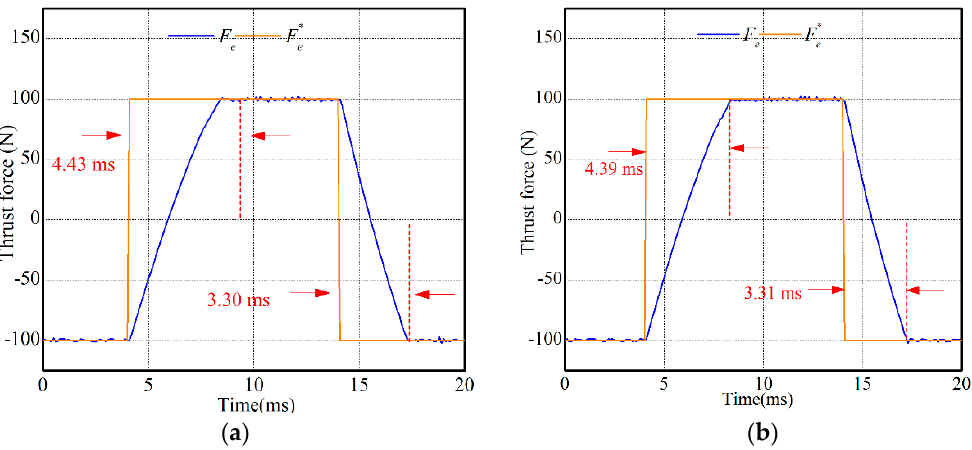
Figure 11. Thrust force response performances: ( a ) MPCC-I and ( b ) MPCC-II.